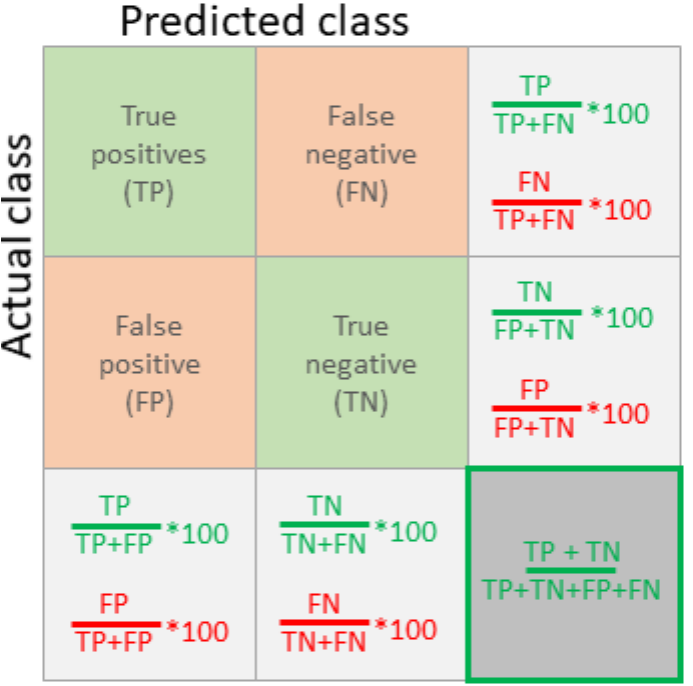
Figure 4. Quantitative measures for the spatial validation of the SRC bare soil